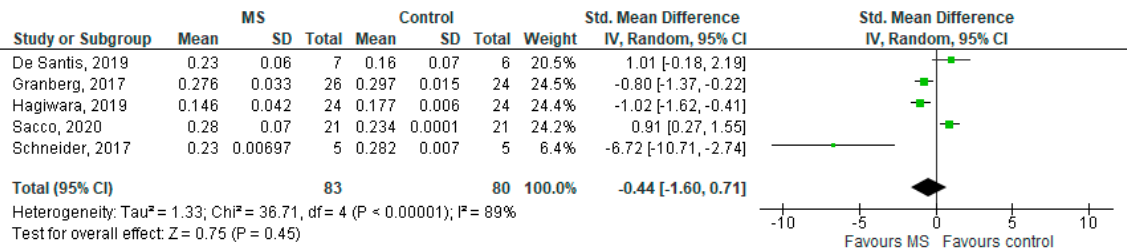
Abbreviations: SD = standard deviation; CI = confidence interval; ODI = Orientation Dispersion Index; MS = multiple